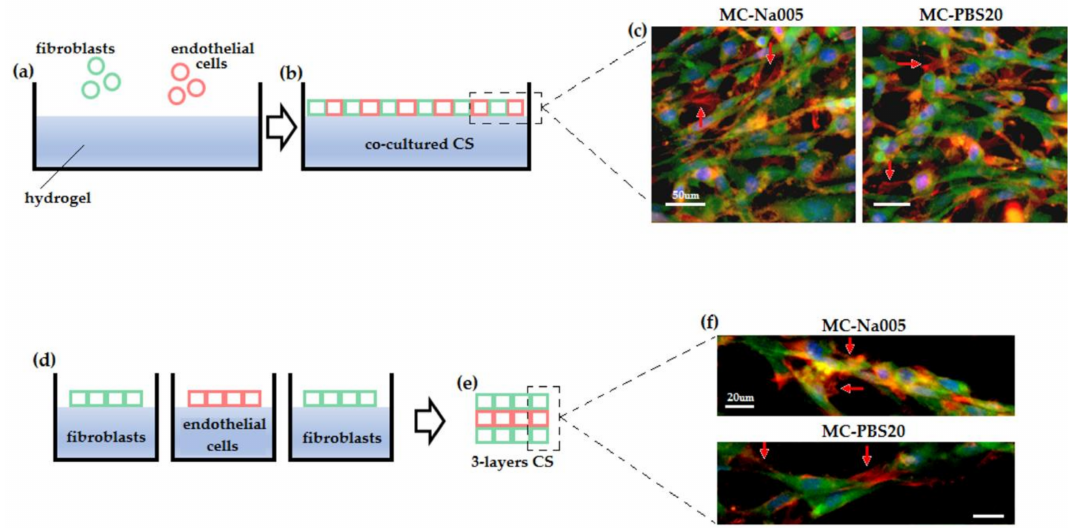
Figure 9. Co-cultured and three-layer CS. When MS1 endothelial cells and NIH-GFP + fibroblasts were co-cultured to obtain multi-species CS ( a , b ), both Na005 and PBS20 MC hydrogels were able to support the presence of both cell populations: both green and red signals could be detected from GFP (NIH) and α -SMA (MS1, highlighted by the red arrows), together with the blue stain for the nuclei ( c ). Moreover, when three single-cell CS were collected and superimposed to obtain a three-layer sandwich ( d , e ), again green and red signals sometimes overlapped, suggesting an active interaction between the cells of the different layers ( f